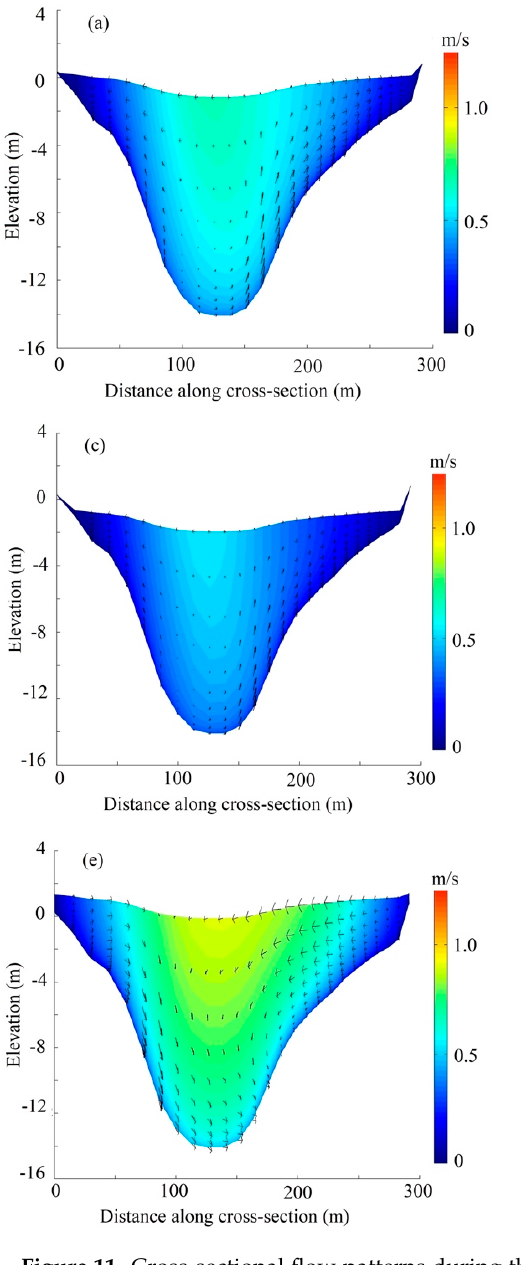
Figure 11. Cross-sectional flow patterns during the spring tide: ( a , b ) Falling period; ( c ) Low water slack; ( d , e ) Rising period; and ( f ) High water slack.